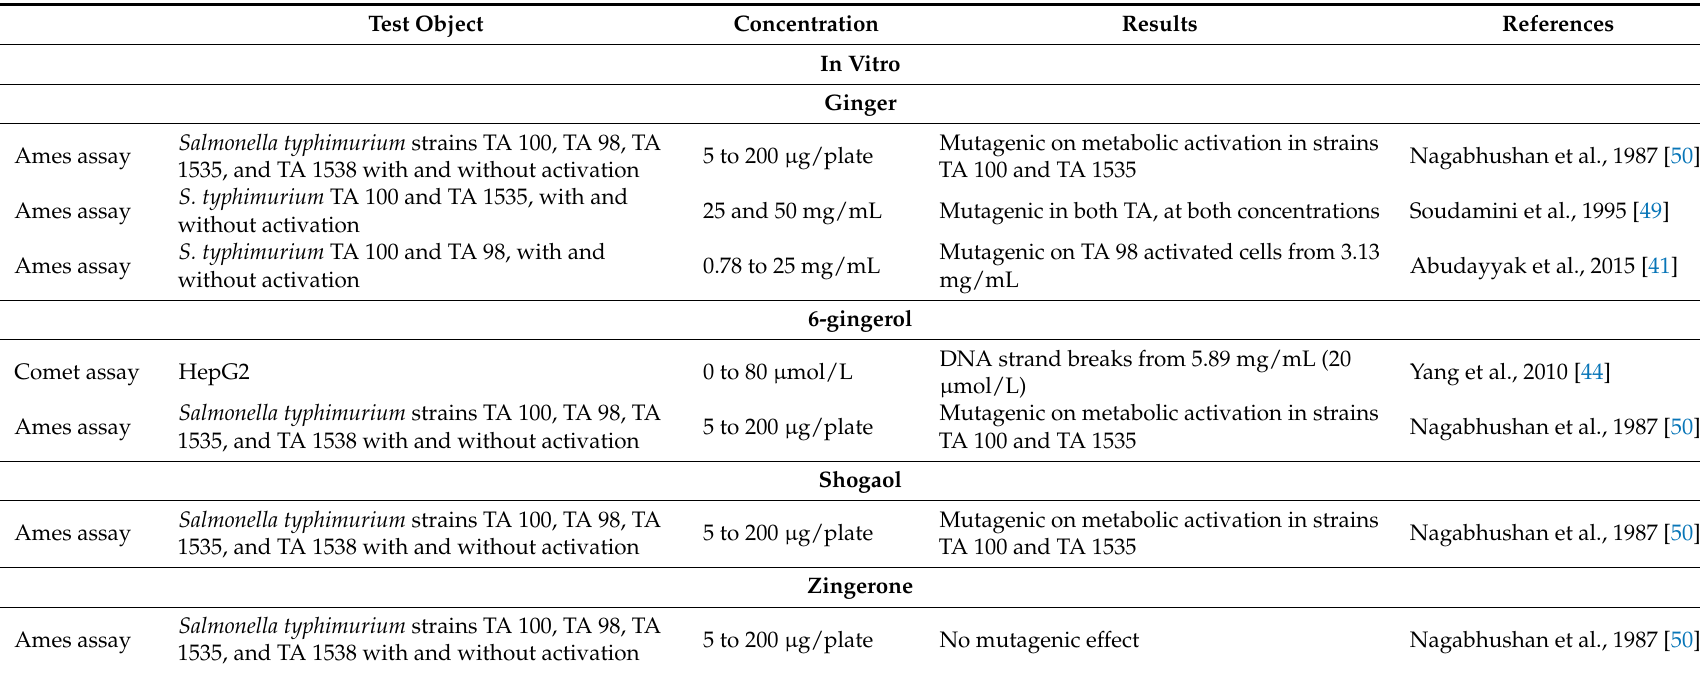
Table 7. Genotoxicity/mutagenicity of ginger and related